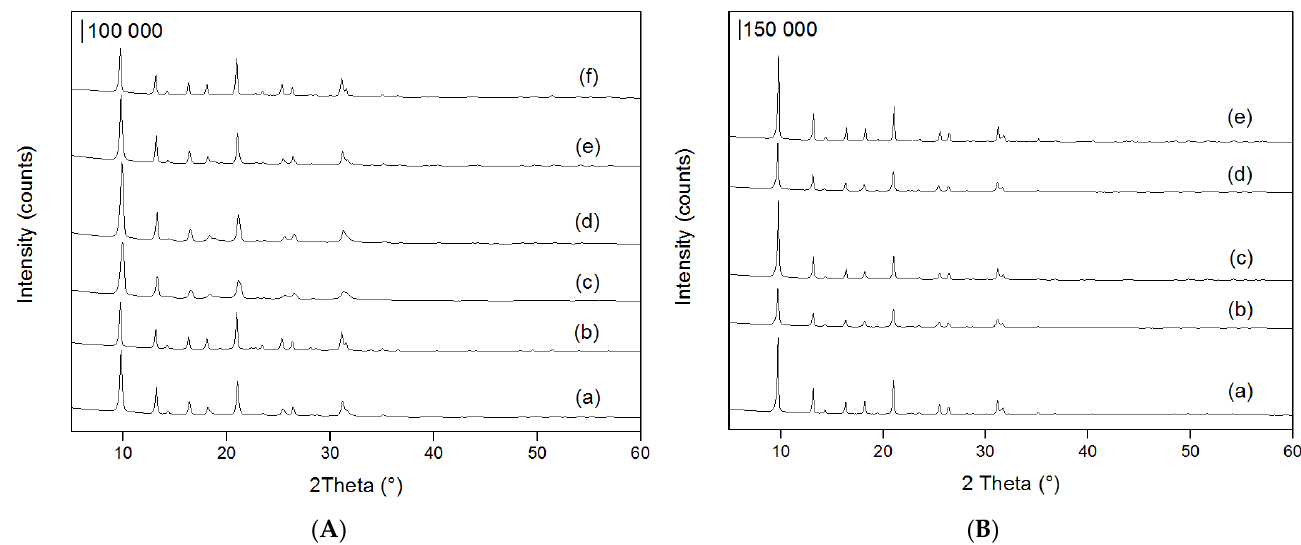
Figure 1. ( A ) XRD patterns of (a) Na ‐ SSZ ‐ 13 ‐ micro ‐ 20, (b) Na ‐ SSZ ‐ 13 ‐ micro ‐ 40, (c) Na ‐ SSZ ‐ 13 ‐ meso ‐ 0.2, (d) Na ‐ SSZ ‐ 13 ‐ meso ‐ 0.4, (e) Na ‐ SSZ ‐ 13 ‐ meso ‐ 0.6, and (f) Na ‐ SSZ ‐ 13 ‐ meso ‐ 0.8; and ( B ) XRD patterns of (a) H ‐ SSZ ‐ 13 ‐ micro ‐ 20, (b) H ‐ SSZ ‐ 13 ‐ micro ‐ 40, (c) H ‐ SSZ ‐ 13 ‐ meso ‐ 0.2, (d) H ‐ SSZ ‐ 13 ‐ meso ‐ 0.4, and (e) H ‐ SSZ ‐ 13 ‐ meso ‐ 0.6. Table 1. The crystallinity of the conventional microporous and hierarchical mesoporous zeolites in Na + and H + forms. Material FWHM 1 Material FWHM 1 Material FWHM 1 0.25